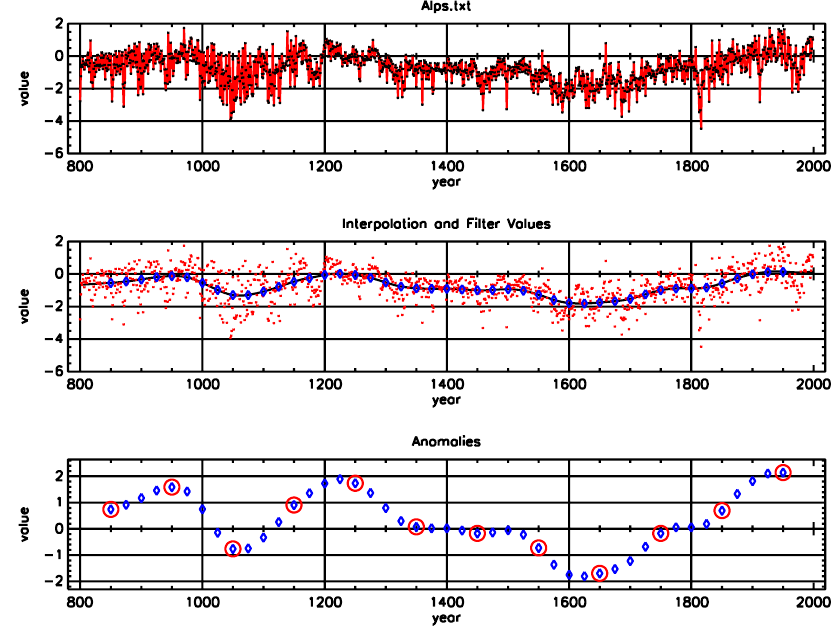
Fig. A1. Example illustrating the transformation of an annually resolved proxy record to a centennially resolved anomaly time series. The top panel shows the raw data, in original units, with its spline fit. The middle panel shows the raw data (red dots) and the 45, 100yr, moving averages (overlap=25yr) between 850AD and 1950AD (blue diamonds). The bottom panel shows the 45, normalized (base period: 11th– 19th centuries) centennial filter values (blue diamonds) and the values of the 12 common centuries (red circles).